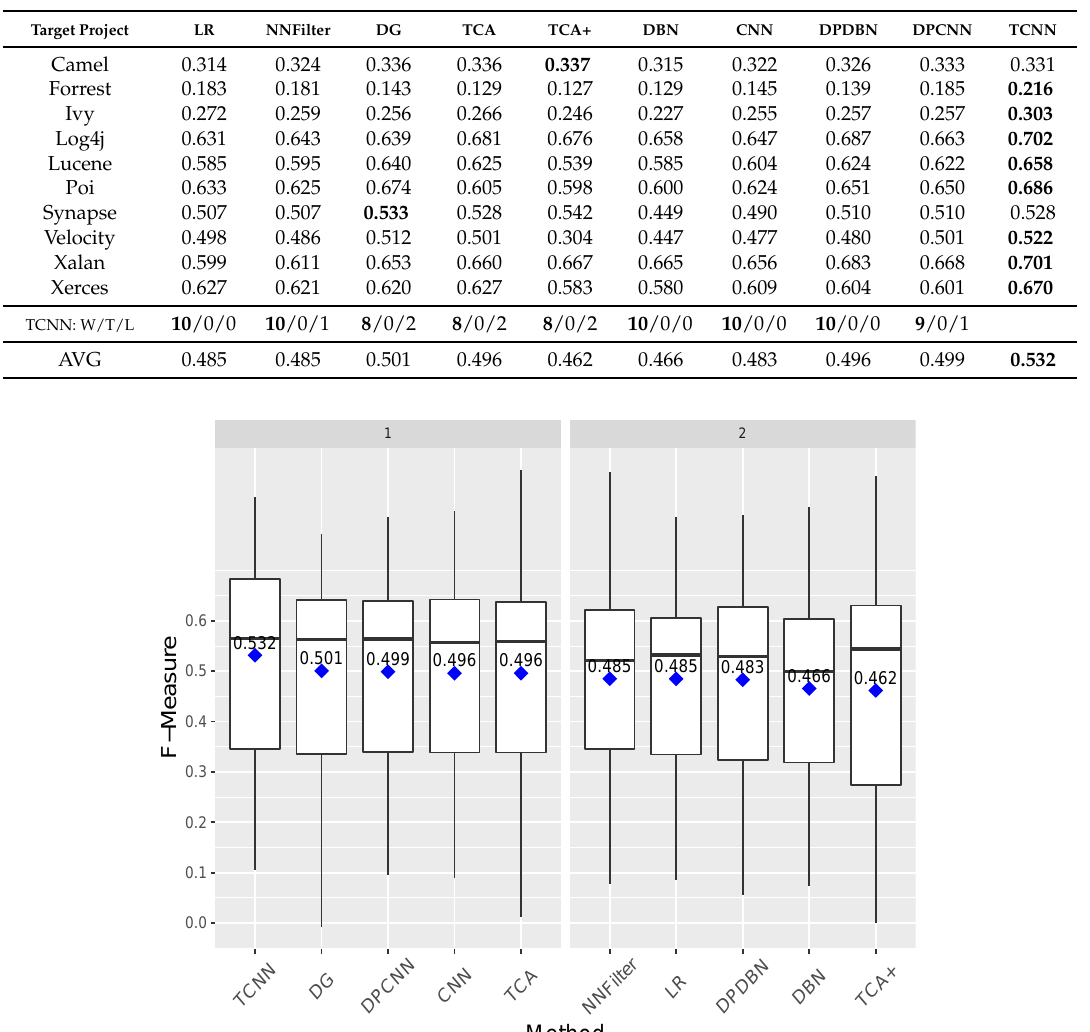
Table 5. Comparison results with 10 approaches on 10 target projects. The better F-measures are in bold. DG, data gravitation; DPCNN, defect prediction through CNN.